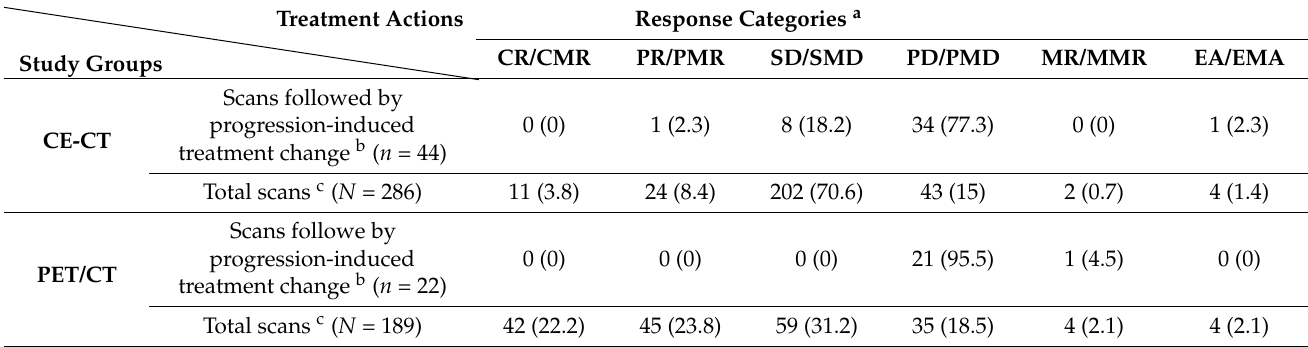
Table 4. Response categories for patients monitored by CE-CT and FDG-PET/CT